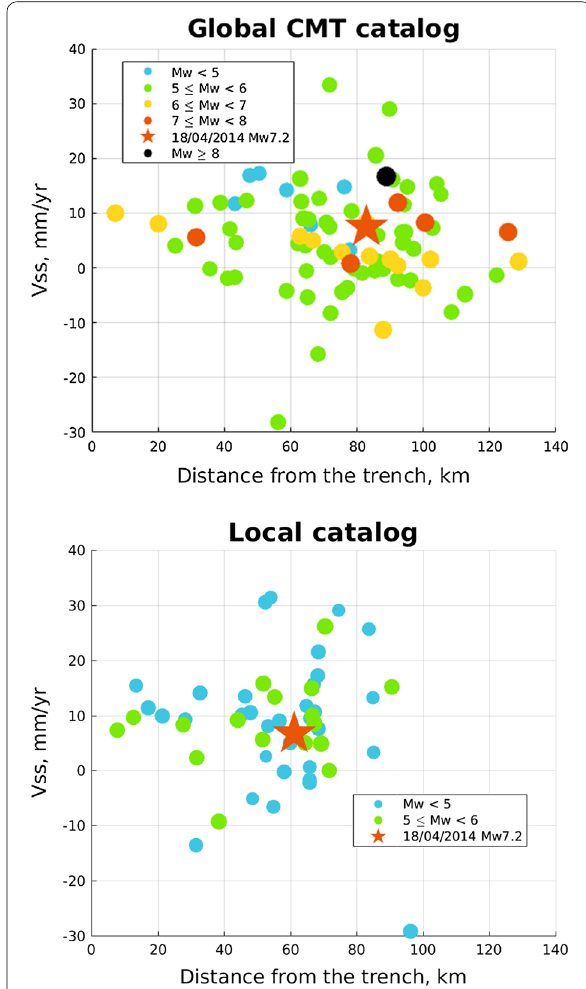
Fig. 7 Secular V ss as a function of the distance from the trench and M w for Global CMT and local